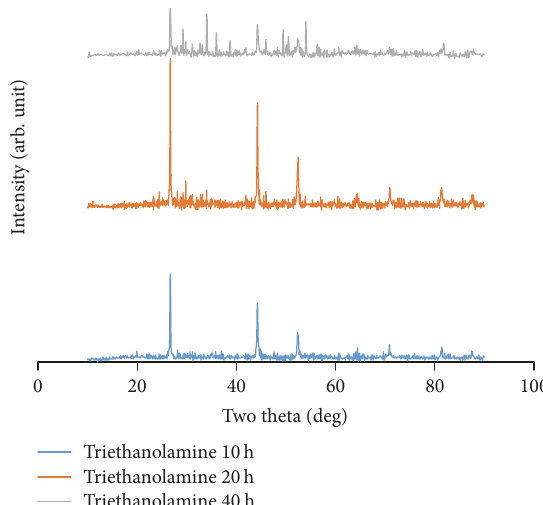
Figure 3: XRD pattern of synthesized CIS powder at 240 ∘ C for 10, 20, and 40 hours with triethanolamine solvent.